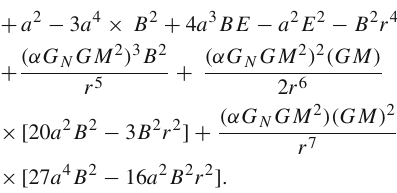
Figure 3 describes the behavior of the effective force as a function of r . In the upper panel, the left graph shows that the effective force acting on particles is more attractive for large values of a magnetic field. The right graph shows the com- parison of the effective force acting on a particle around